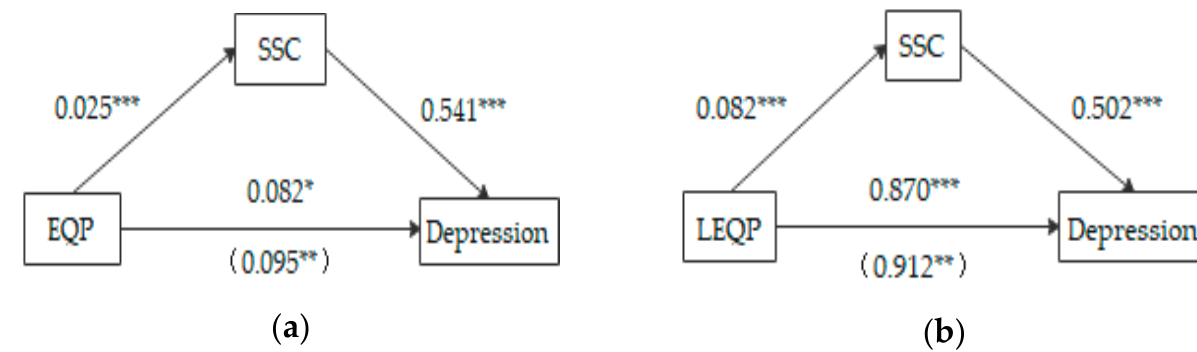
Table 4. Non-standardized mediation analysis results.